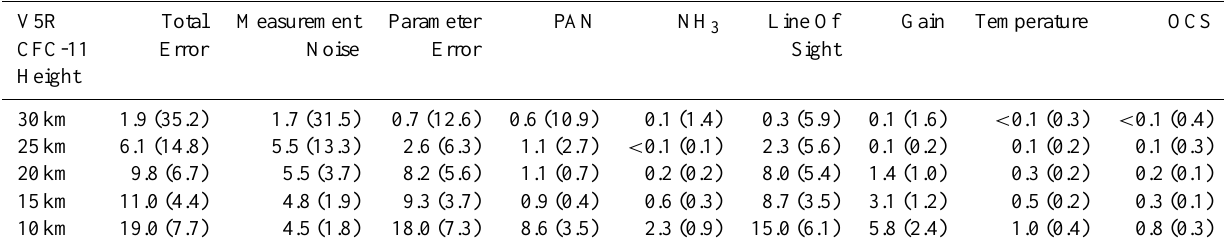
Table 3. Error budget of a V5R CFC11 220 (RR nominal mode) retrieval from spectra recorded at 37 ◦ N, 29 ◦ W on 19 September 2009 at 00:11 UTC for selected altitudes. The errors are given in units of pptv(%). Details as for Table 2.